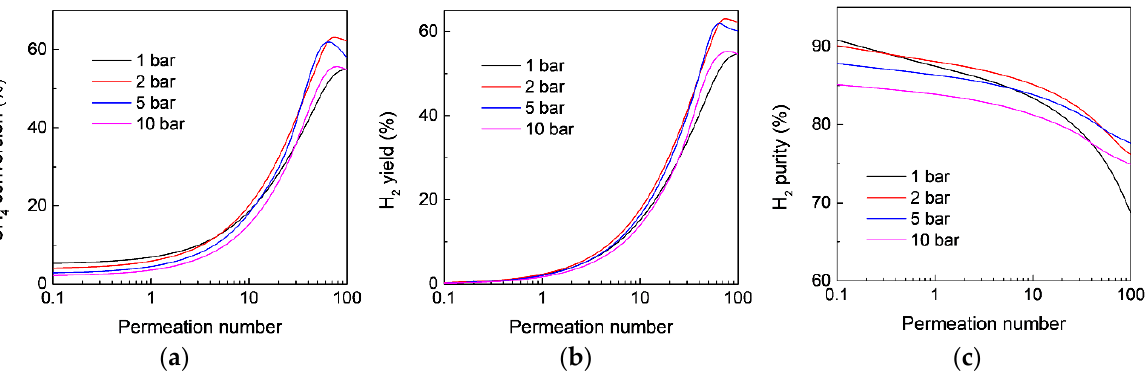
Figure 7. Effect of the feed pressure on ( a ) CH 4 conversion, ( b ) H 2 yield, and ( c ) H 2 purity as a function of the permeation number for MDA in the membrane reactor. (Simulation conditions: T = 873 K, Da = 5, α H = 200, α CH = Knudsen selectivity, p l = 0.05 bar). 2 / CH 4 4 / C 6 H 6